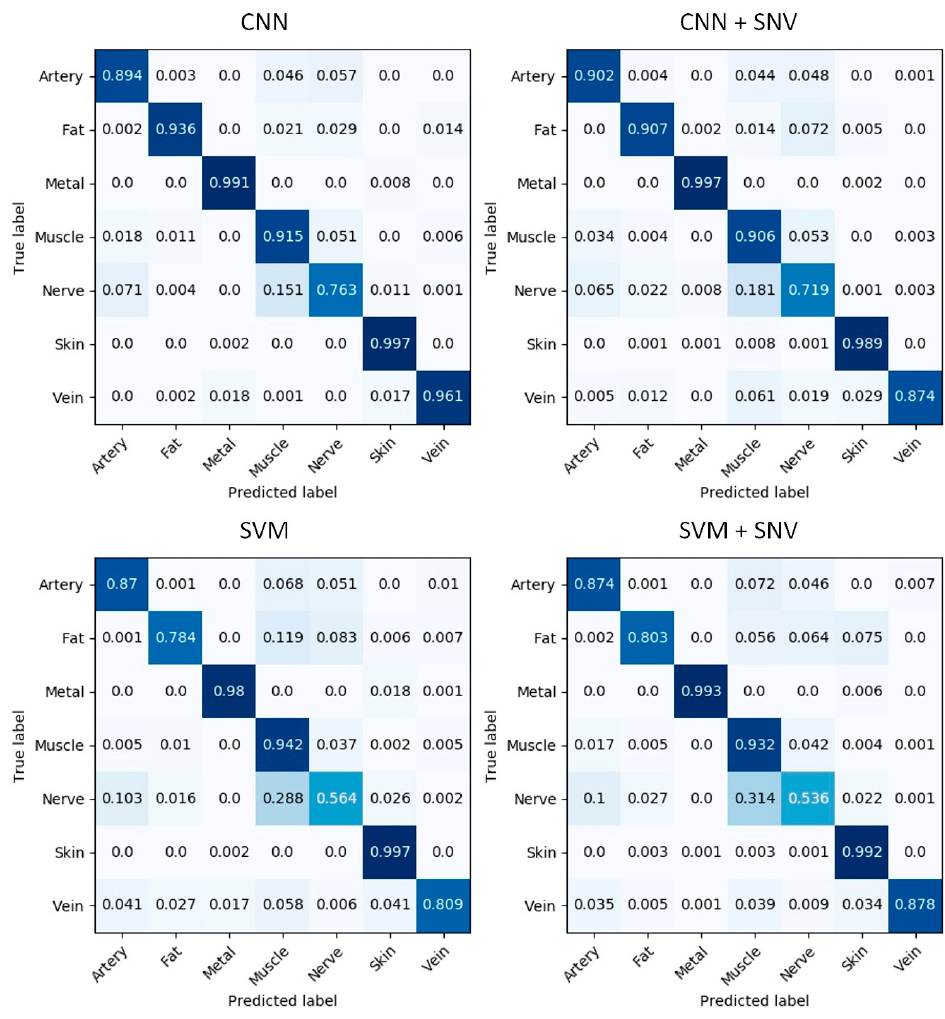
Figure 6. Confusion matrices: predictive performance of 4 different models visualized as confusion matrices.